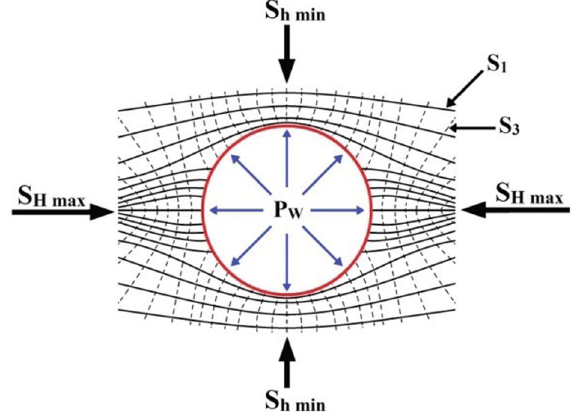
Fig. 2 The path of the main stresses around the well based on the Kirsch equations (the well wall is a free surface, and the well axis is in the direction of vertical stress)